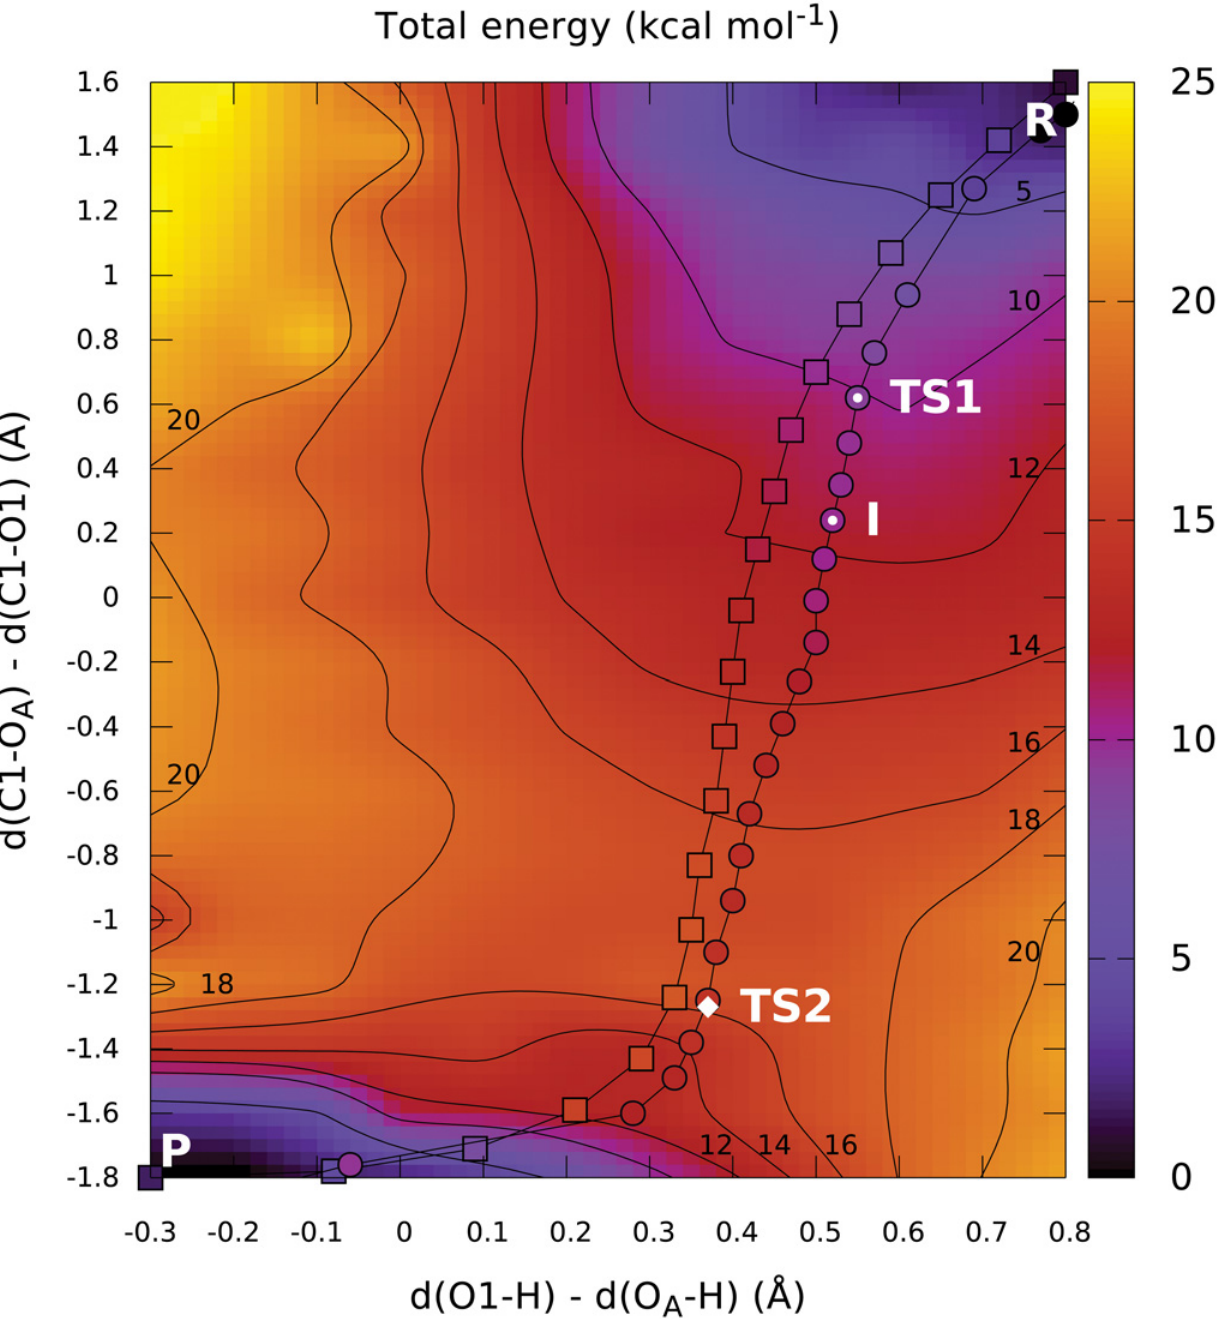
Fig 4. Two-dimensional PES obtained by scanning distance differences. The initial (squares) and optimized (circles) NEB paths are shown. The color of the individual path points represents the energy of the corresponding image. The position of the optimised transition state TS2 is denoted by a white diamond. The images corresponding to the estimates of two more stationary points (TS1 and intermediate) predicted by higher-level density functionals are labelled.